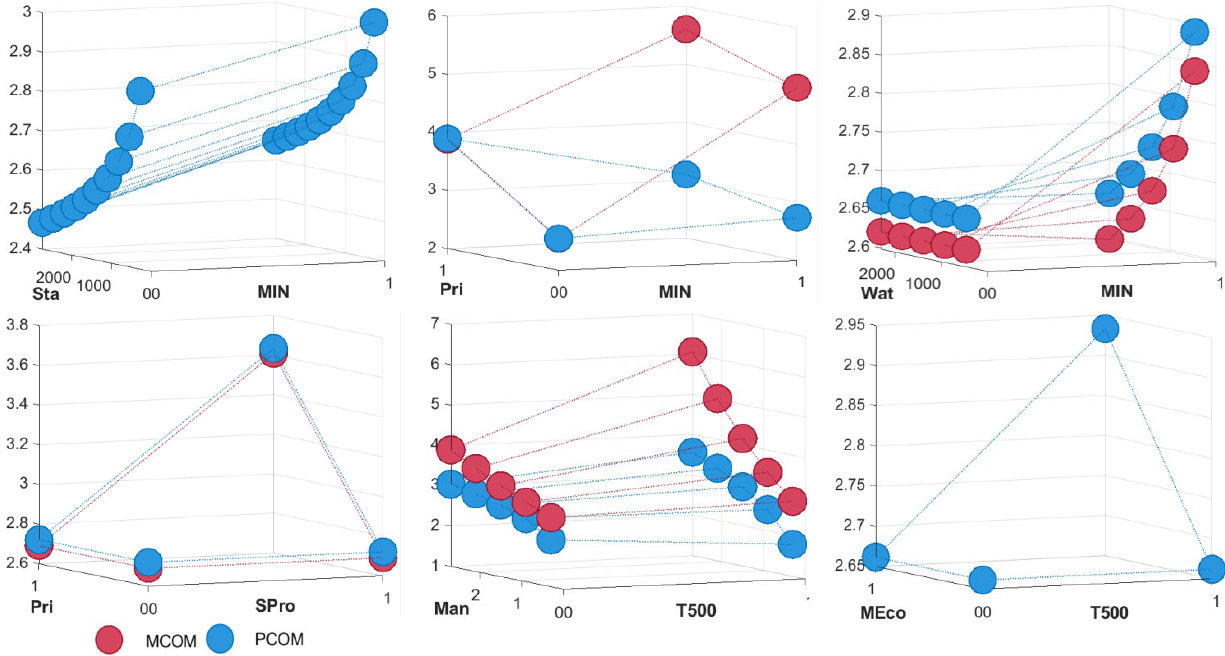
Figure 6. Price model chart of developer types.